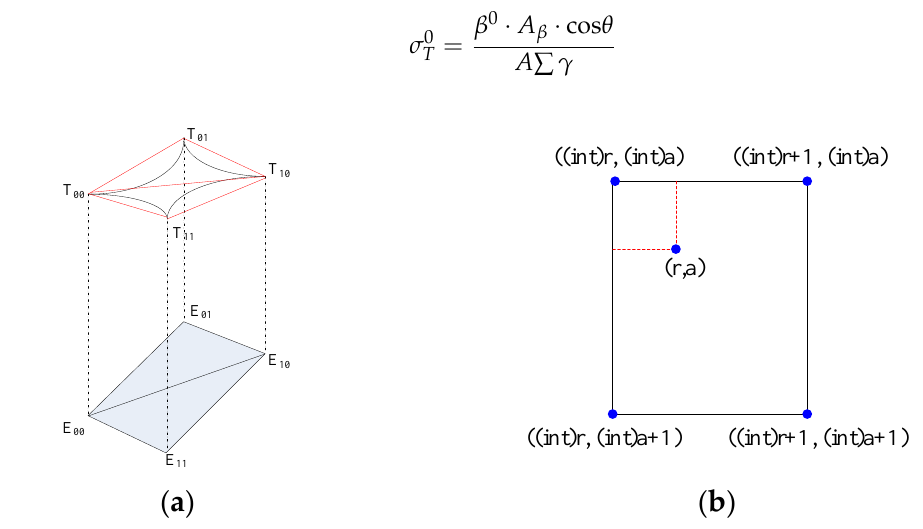
Figure 2. DEM projection: ( a ) DEM area calculation; and ( b ) bilinear interpolation.